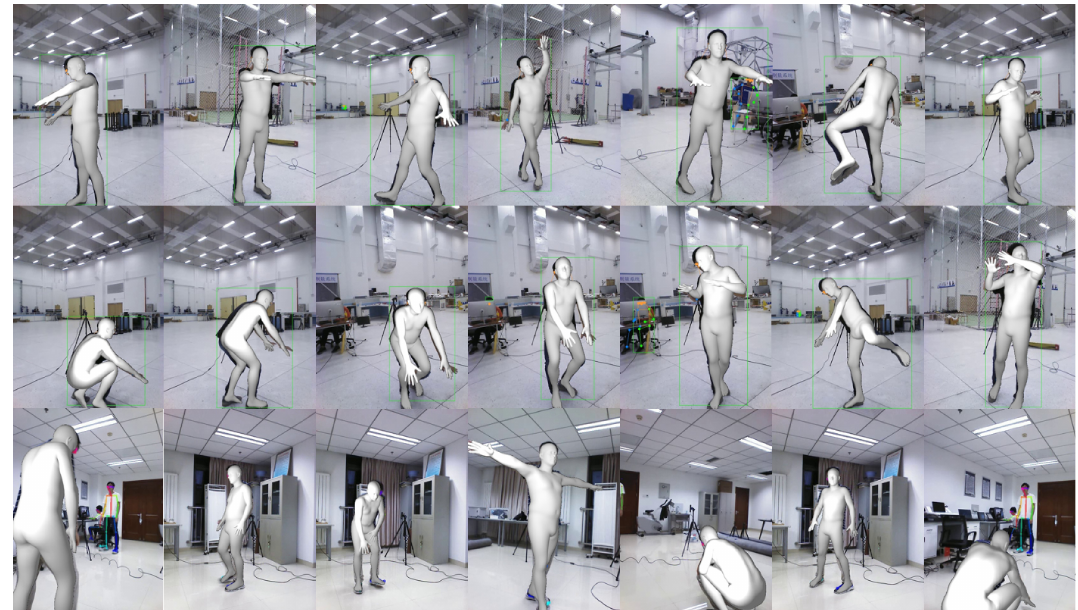
Figure 10. Qualitative results of the ground verification test